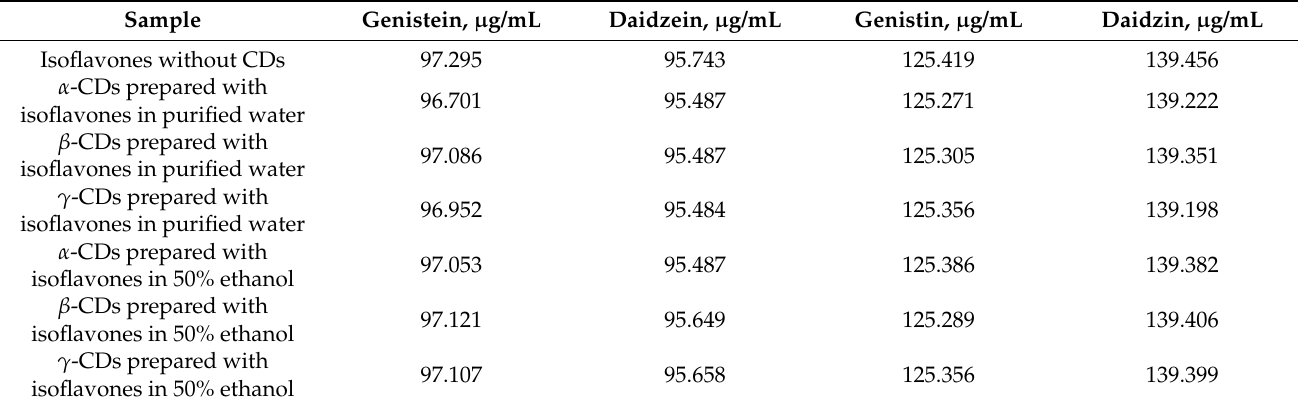
Table 3. Concentrations of isoflavones recovered from the samples with CDs.